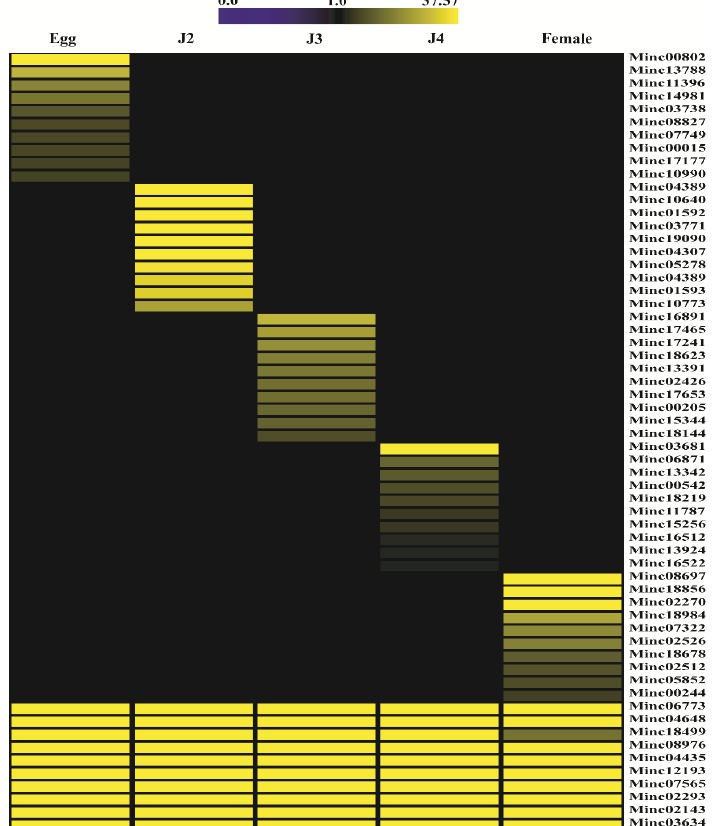
Figure 4. Heat map of selected stage-specific highly expressed mRNA (FPKM) profiles at all develop- mental stages. “Minc” indicates a stage-specific transcript gene ID. Darker yellow colors indicate higher expression levels of genes, and black indicates no expression. The selected mRNAs were validated using quantitative real-time PCR (Figure